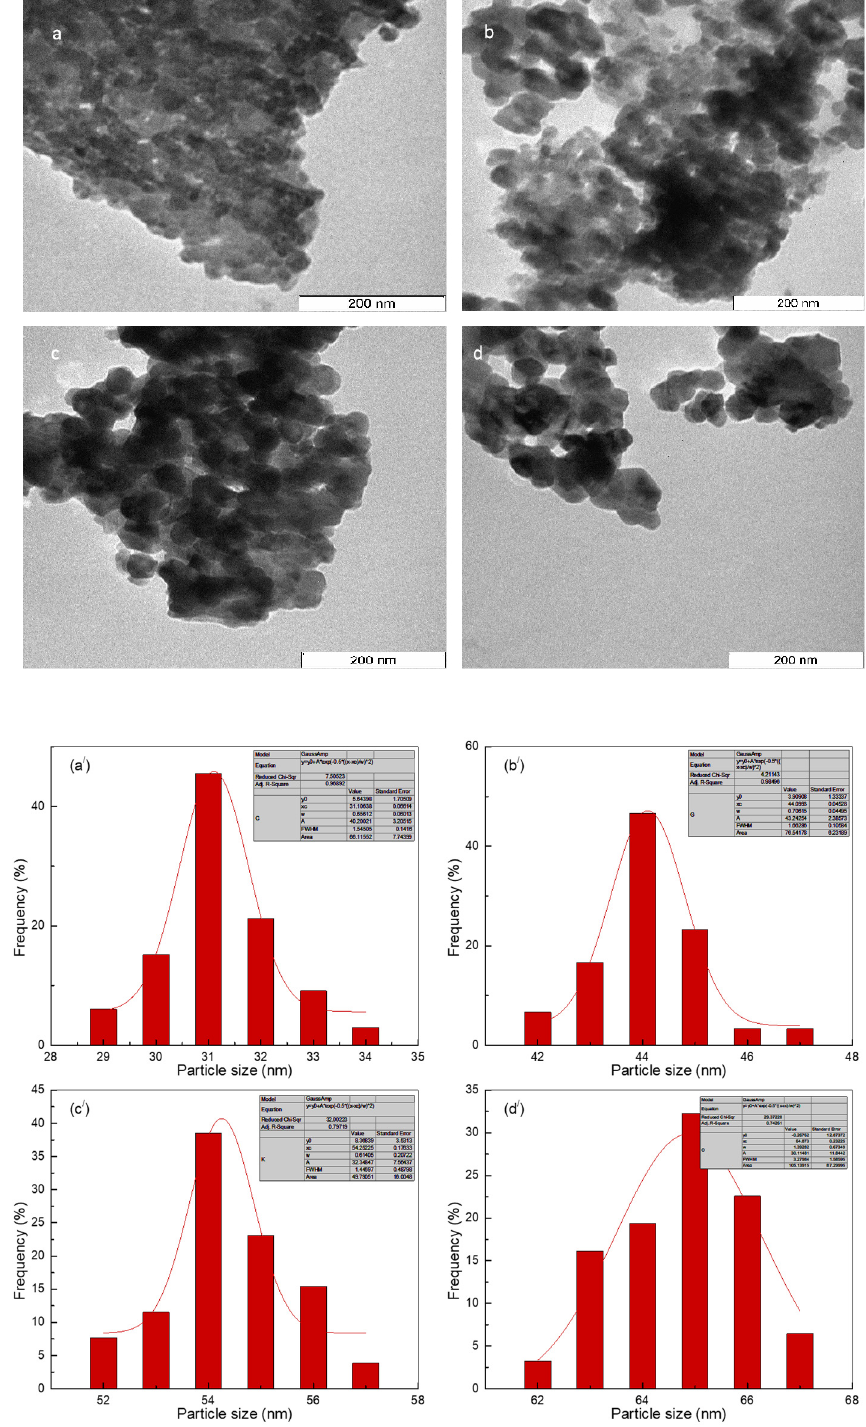
Figure 9. TEM images and particle size distribution of bunsenite cadmium oxide nanoparticles at ( a , a / ) 500, ( b , b / ) 600, ( c , c / ) 700, and ( d , d / ) 800 °C calcination